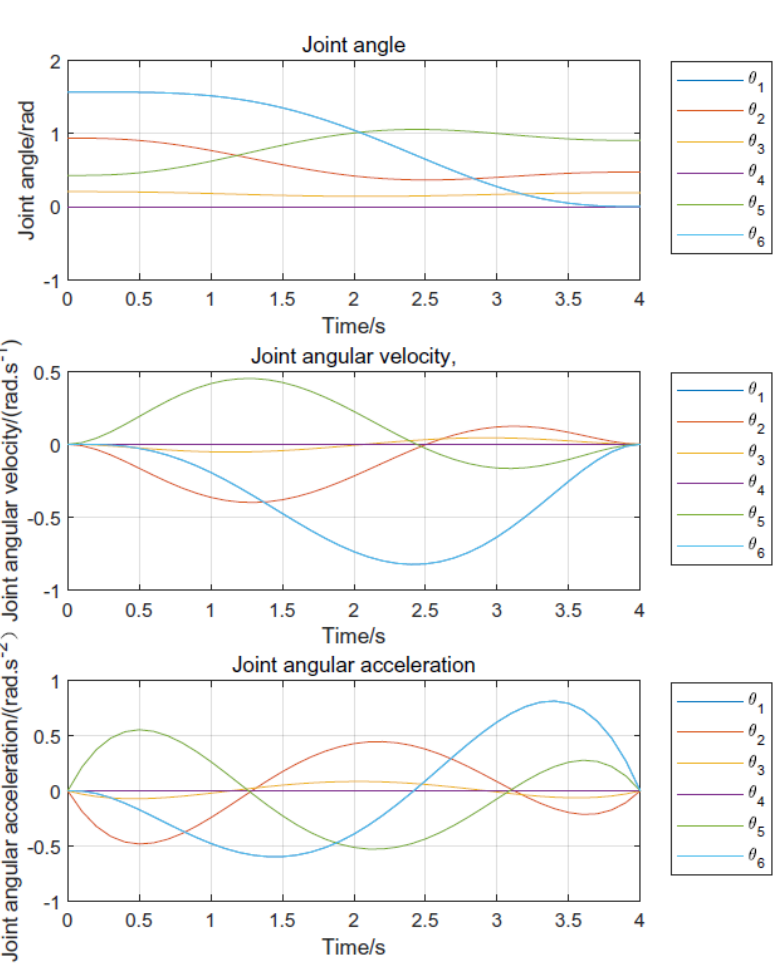
Figure 9. The curve of displacement, velocity and acceleration of each joint.